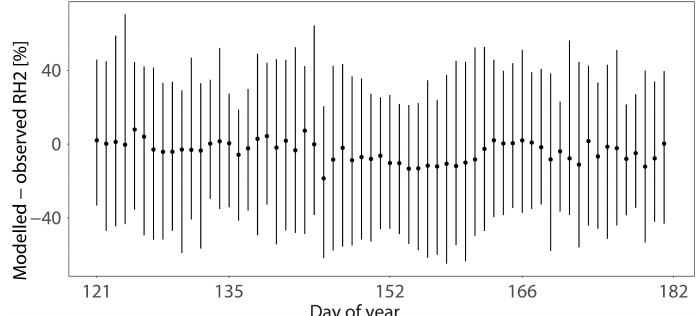
Figure 2. Min, max and median values (black dots) for modeled—observed hourly RH2, summarized for each day and all